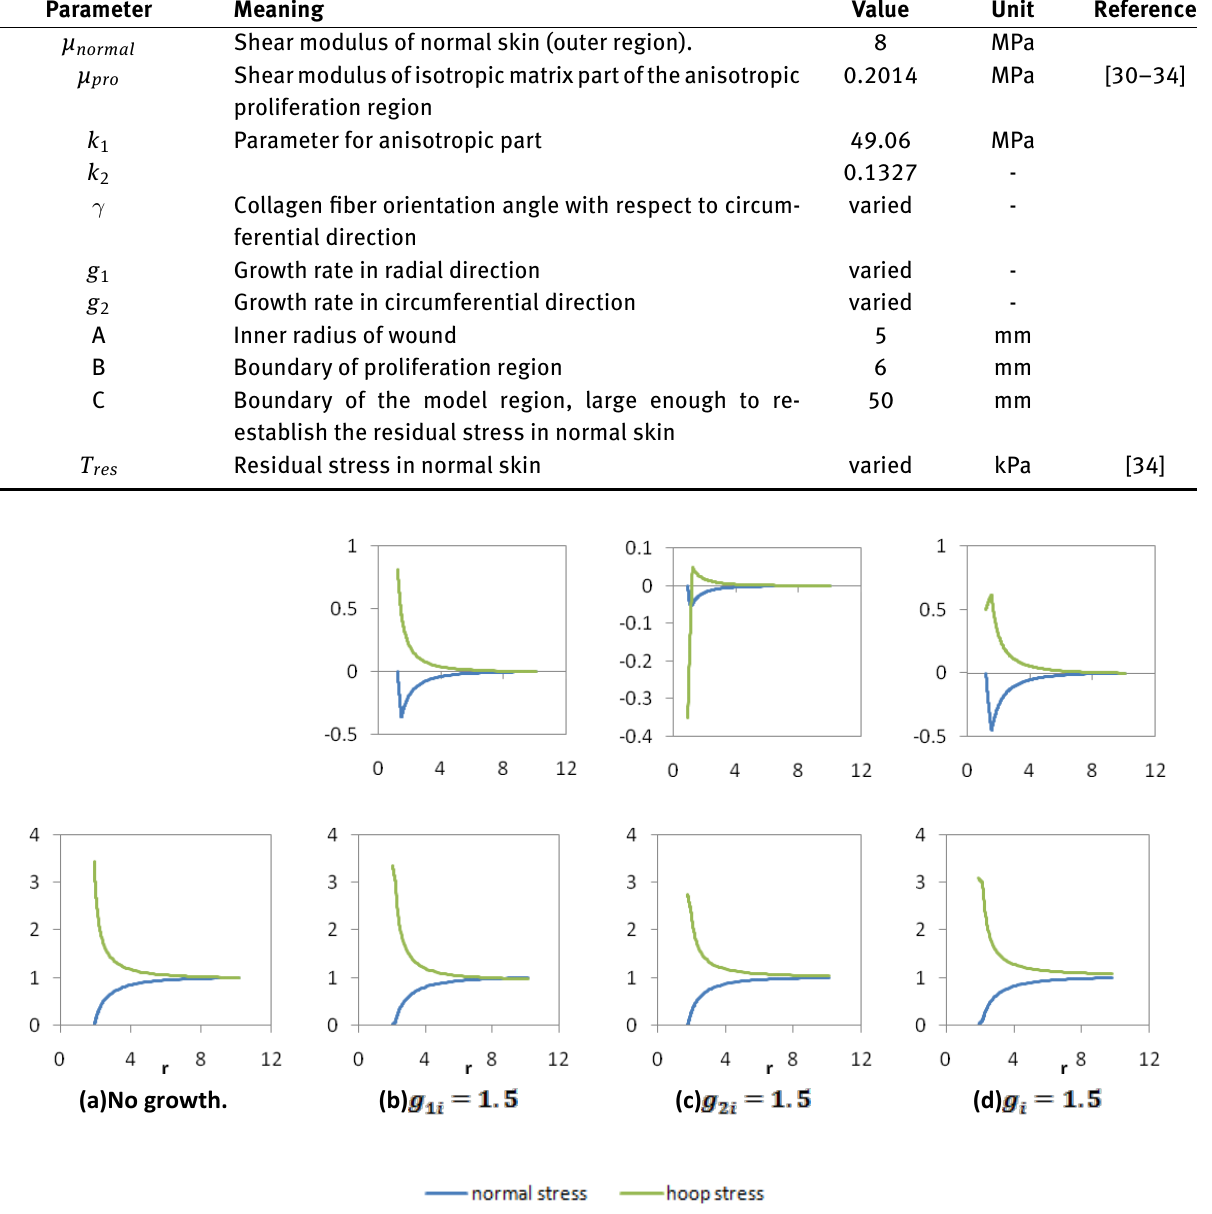
Figure 10: Stress level at wound edge before and after growth. 𝛾 = π /18. First row: P_external=0.0; second row: P_external=1.0. (a) No growth. (b)Inner layer radial growth =1.5. (c)Inner layer circumferential growth =1.5. (d)Inner layer isotropic growth